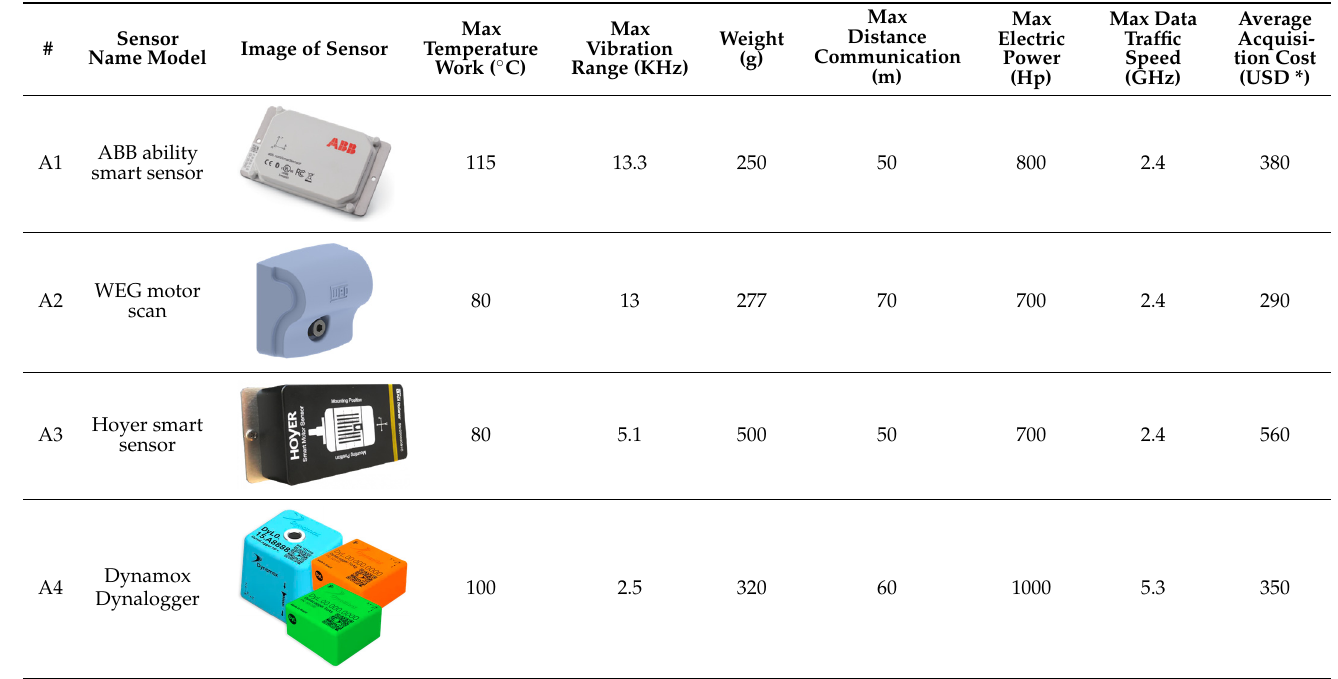
Table 5. Decision parameters of smart sensors.